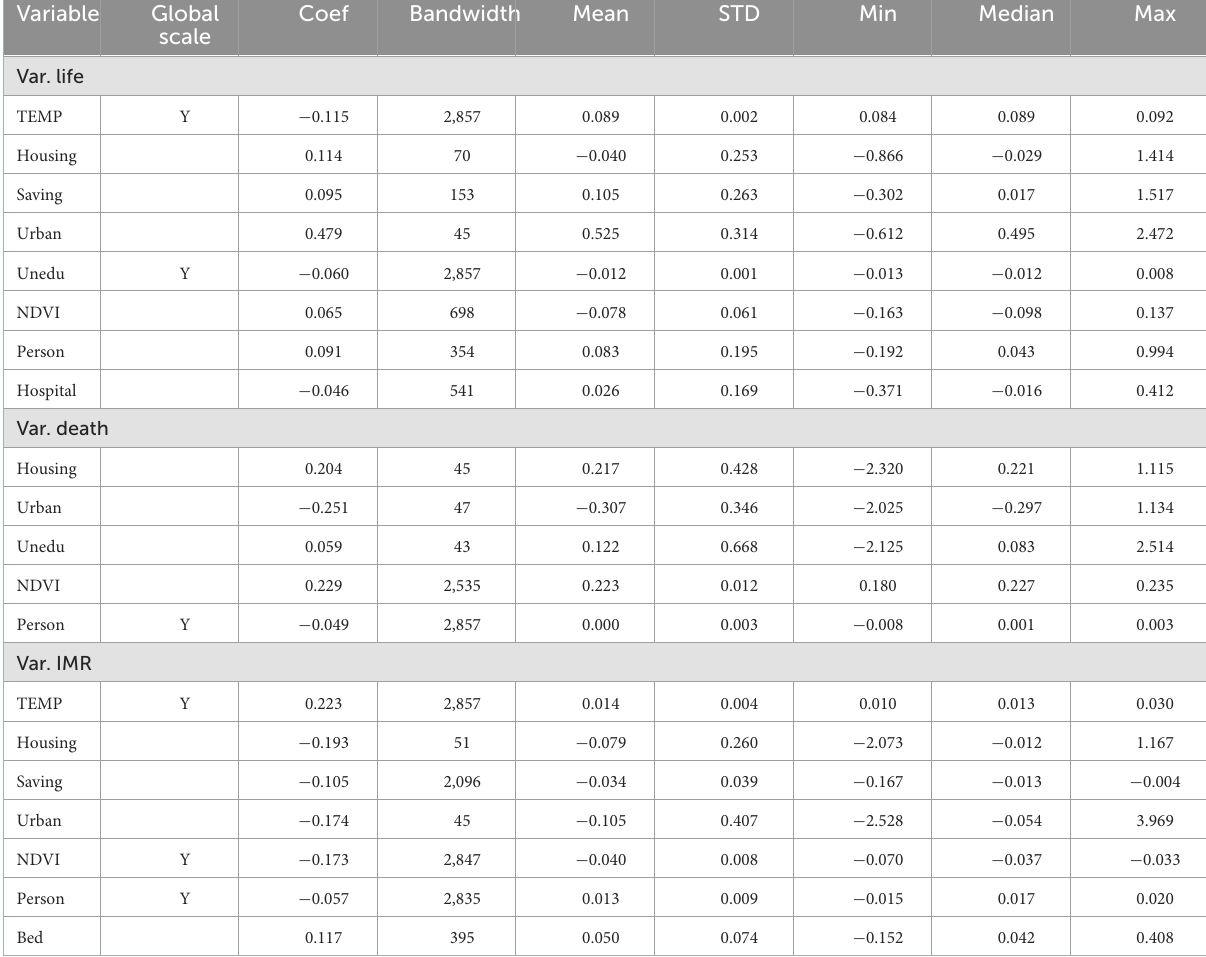
TABLE 8 Statistical description of MGWR coefficients,